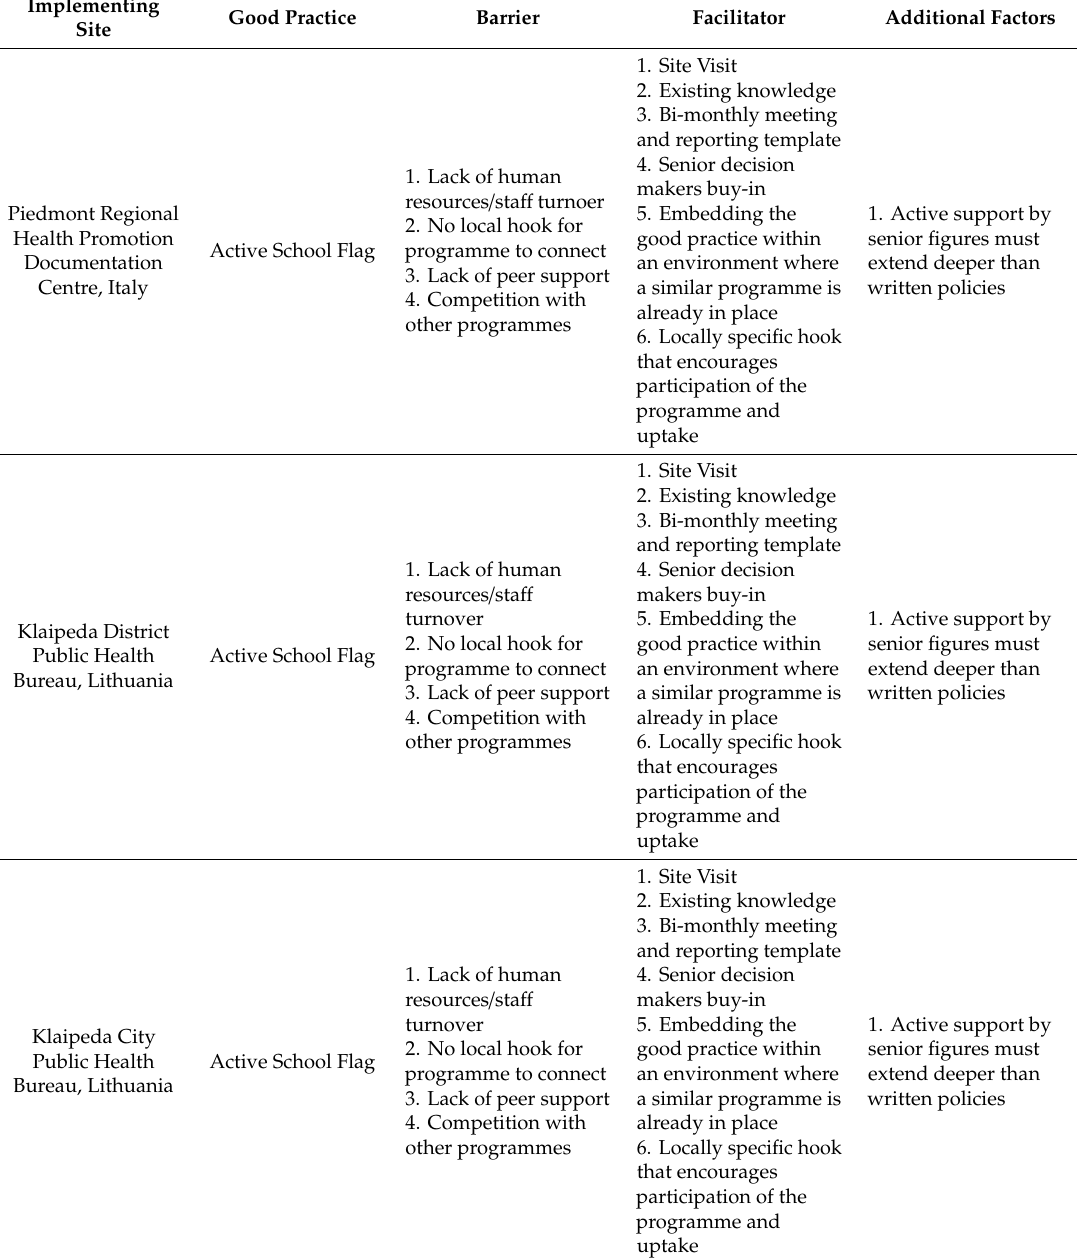
Table 1. Table of barriers and facilitators for transfer and